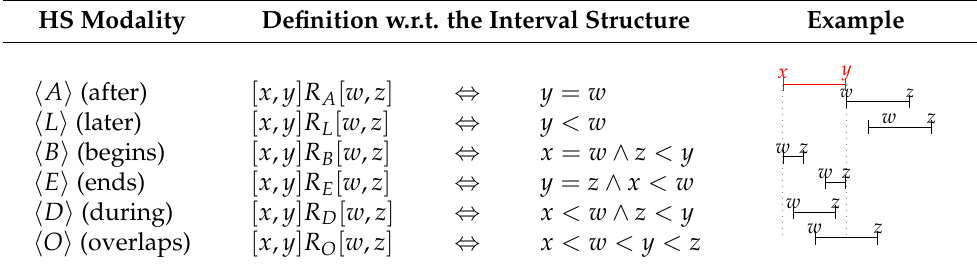
Table 1. Allen’s relations and their logical notation. HS, Halpern and